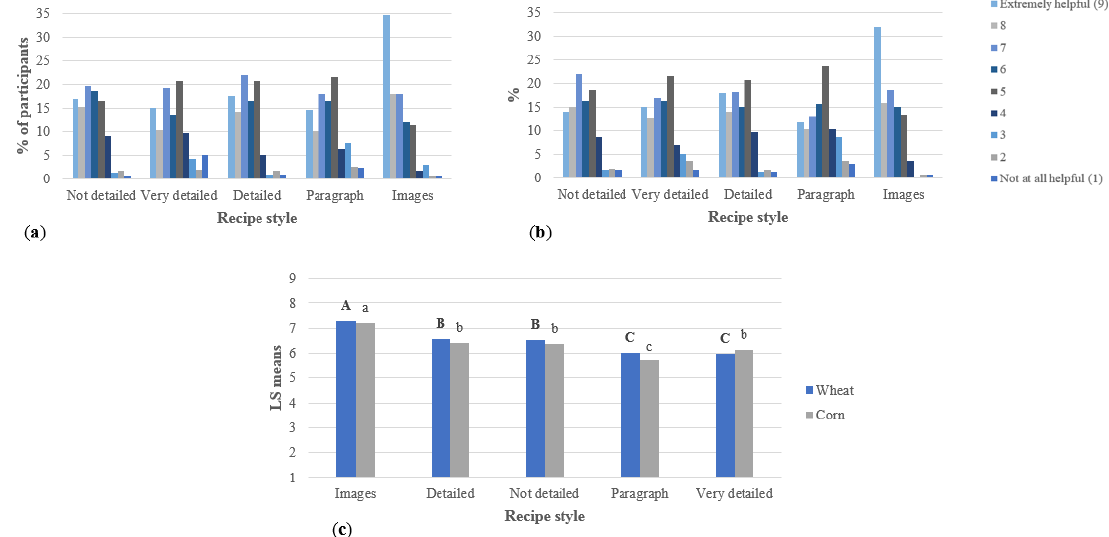
Figure 5. Helpfulness of the format of the recipes (per study, n = 300), including ( a ) wheat study, ( b ) corn study, and ( c ) ANOVA. For the ANOVA, statistical comparisons are within wheat and corn recipes: bold, uppercase letters represent the wheat recipes; not bold, lowercase letters represent the corn recipes. Different letters among studies represent significantly different means ( p < 0.05).